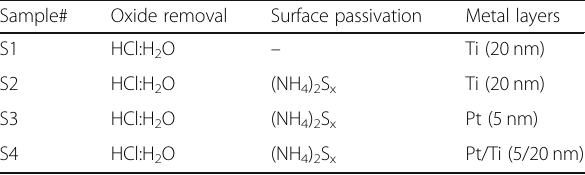
Table 2 Description of surface chemical treatments and metal layers deposited on GaAs (110) substrates for GIXRD analysis Sample# Oxide